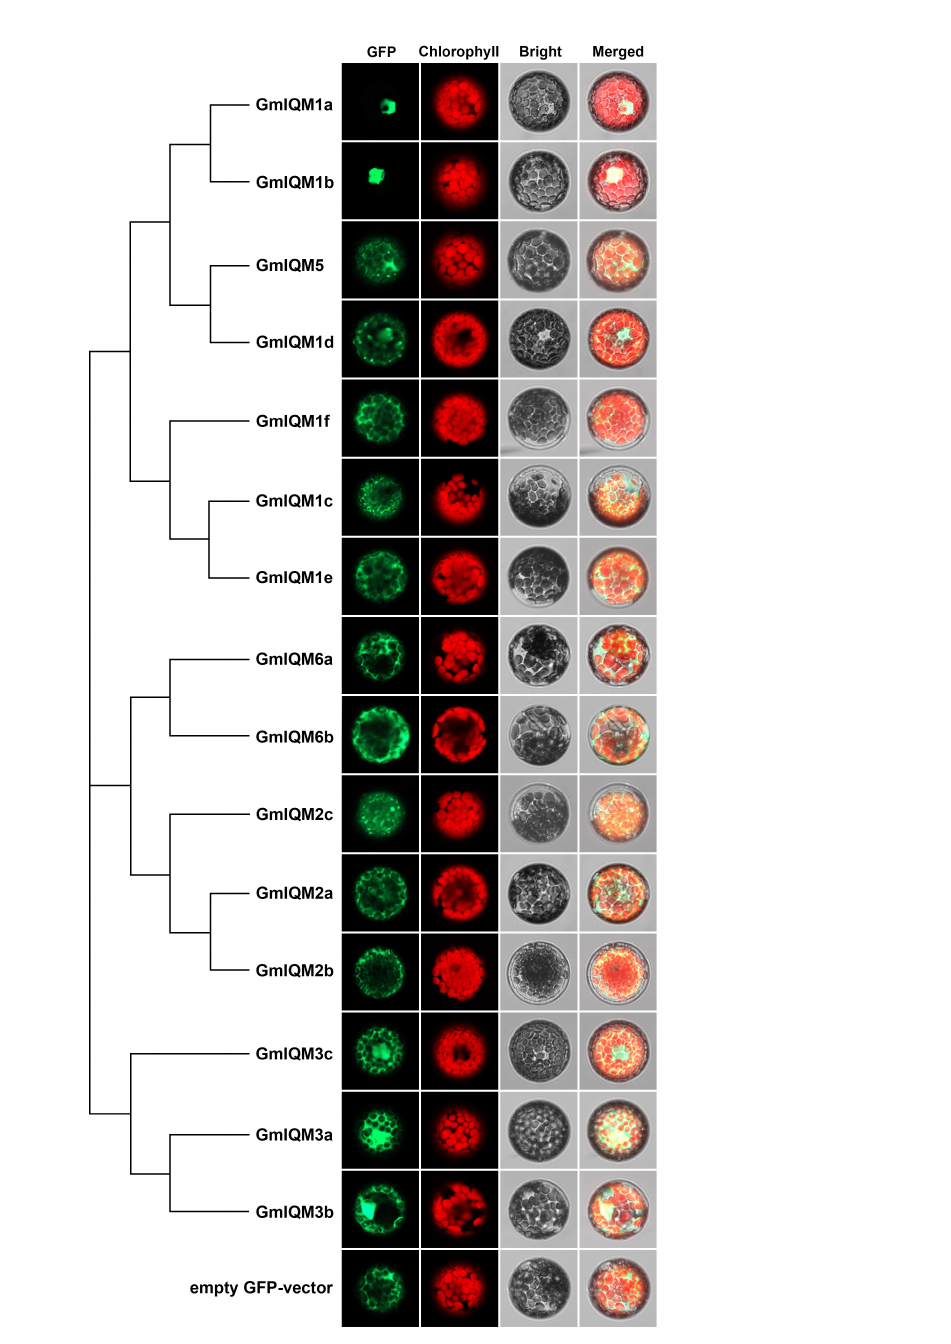
FIGURE 6 Subcellular localization of fi fteen GmIQM proteins in Arabidopsis protoplasts.The plasmids containing pGreenII-35S-GFP-GmIQMs vector were transformed into protoplasts isolated from the leaves of 4-week-old Col-0 plants. After 16 h of incubation, the GFP signals were observed using a laser confocal microscope. Transformed pGreenII-35S-GFP empty vector was employed as the negative control. GFP, green fl uorescent protein; Chlorophyll, chlorophyll auto- fl uorescence; Bright, bright fi eld; Merged, merged GFP, chlorophyll and